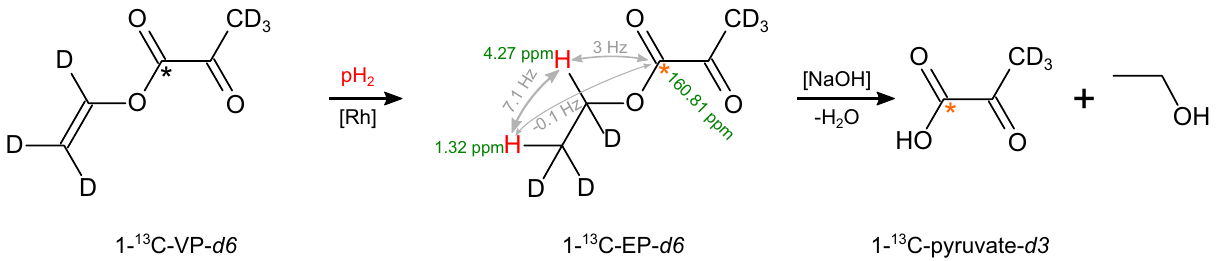
Figure 1. Principle PHIP-SAH experiment with 1- 13 C-vinyl pyruvate- d6 (1- 13 C-VP- d6 ) as a precursor. First, 1- 13 C-VP- d6 is hydrogenated in the presence of a rhodium catalyst [Rh] to yield 1- 13 C-ethyl pyruvate- d6 (1- 13 C-EP- d6 ). Second, spin order is transferred from protons to 13 C (red star). Finally, after the addition of NaOH, hyperpolarized pyruvic acid and ethanol are produced. Chemical shifts, 1 H- 1 H and 1 H- 13 C J-coupling constants, and chemical shifts for 1- 13 C-EP- d6 are given 51